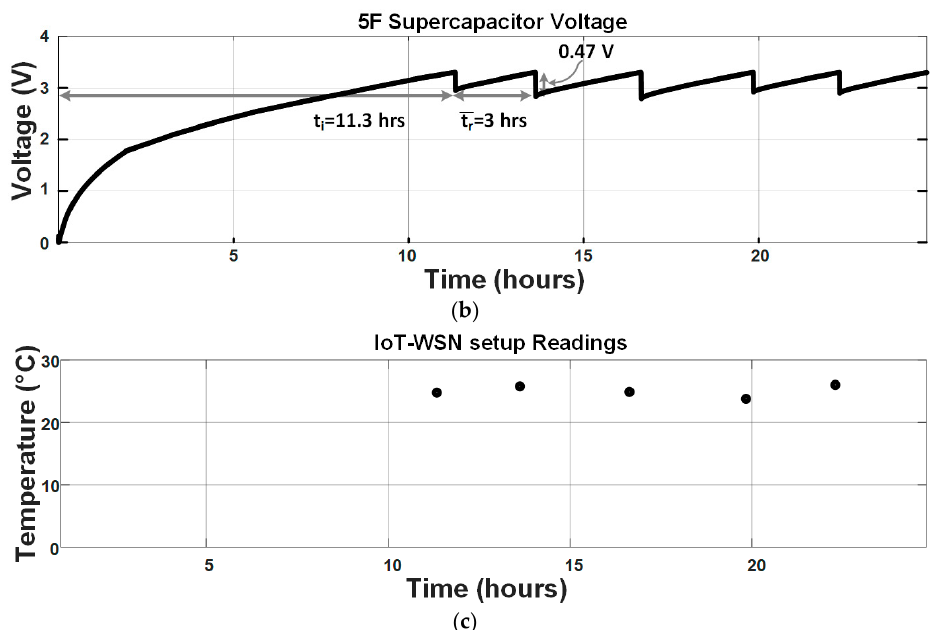
Figure 10. Internet of things sensor node. ( a ) Hardware setup; ( b ) supercapacitor voltage waveform and ( c ) temperature measurements.